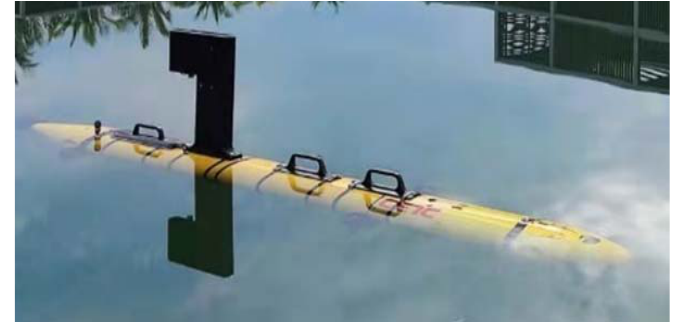
Figure 19. The AUV attitude ‐ control experimental environment. The initial attitude angle is adjusted to about 25 degrees and 15 degrees by external force. The angles of well-designed AUV will gradually approach zero after the external force stops. It is obvious from Figure 20 that the attitude effect of the IISMC-based method can converge faster than the original PID-based attitude-control